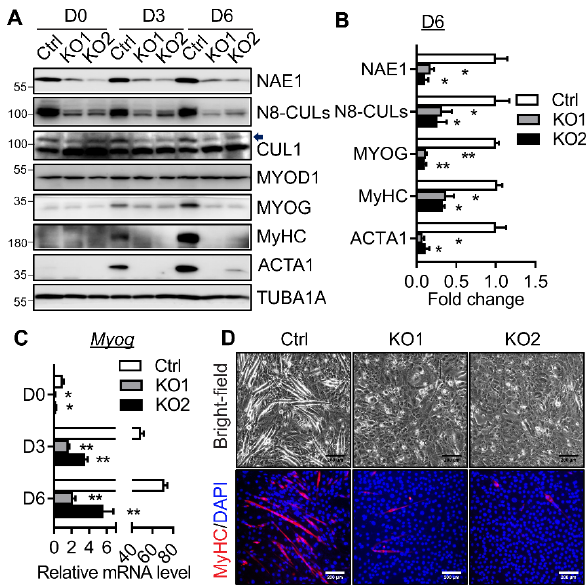
Figure 3. Neddylation inhibition mediated by knockout of NAE1 inhibits C2C12 differentiation. C2C12 cells were infected with lentiviruses expressing gRNAs (gRNA1 and gRNA2) against murine Nae1 , respectively, to generate bulk cultures of cells with NAE1 knockout (KO1 and KO2). Cells infected with lentiviruses expressing no gRNA were used as controls (Ctrl). ( A ) Western blot analysis of NAE1, neddylated Cullins (N8-CULs), CUL1, myogenic transcription factors, and muscle differen- tiation markers during the differentiation. Arrow indicates neddylated CUL1. ( B ) Quantifications of protein expressions as normalized to TUBA1A at D6. Data were presented as fold changes with Ctrl set at 1. ( C ) qRT-PCR analysis of Myog gene expression at D0, D3, and D6 of myoblast differentiation. ( D ) Representative bright-field and immunofluorescence images at 6 days in differentiation medium. Cells were stained with MyHC (red), and nuclei were counterstained with DAPI (blue). Scale bar: 200 µ m. * p < 0.05; ** p < 0.01 vs. Ctrl. One-way ANOVA. Three independent